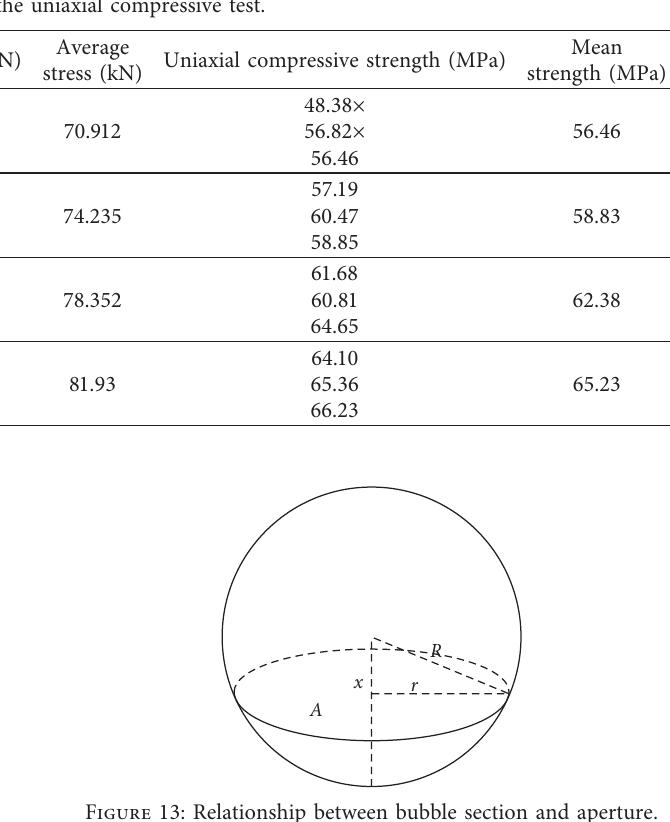
Figure 11: Trend curve of compressive strength-stirring rate relation.